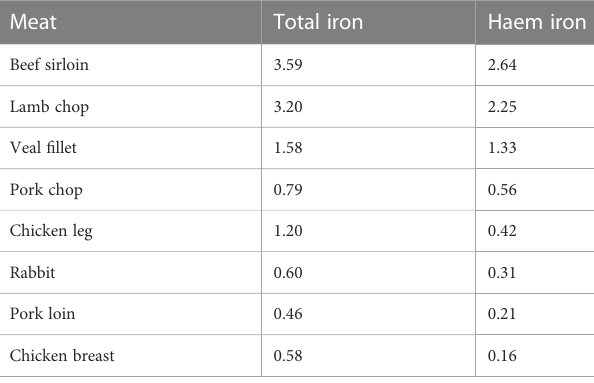
TABLE 2 Haem and non-haem iron content (mg/100g) of different types of cooked meat (Lombardi-Boccia et al 2002). Meat Total iron